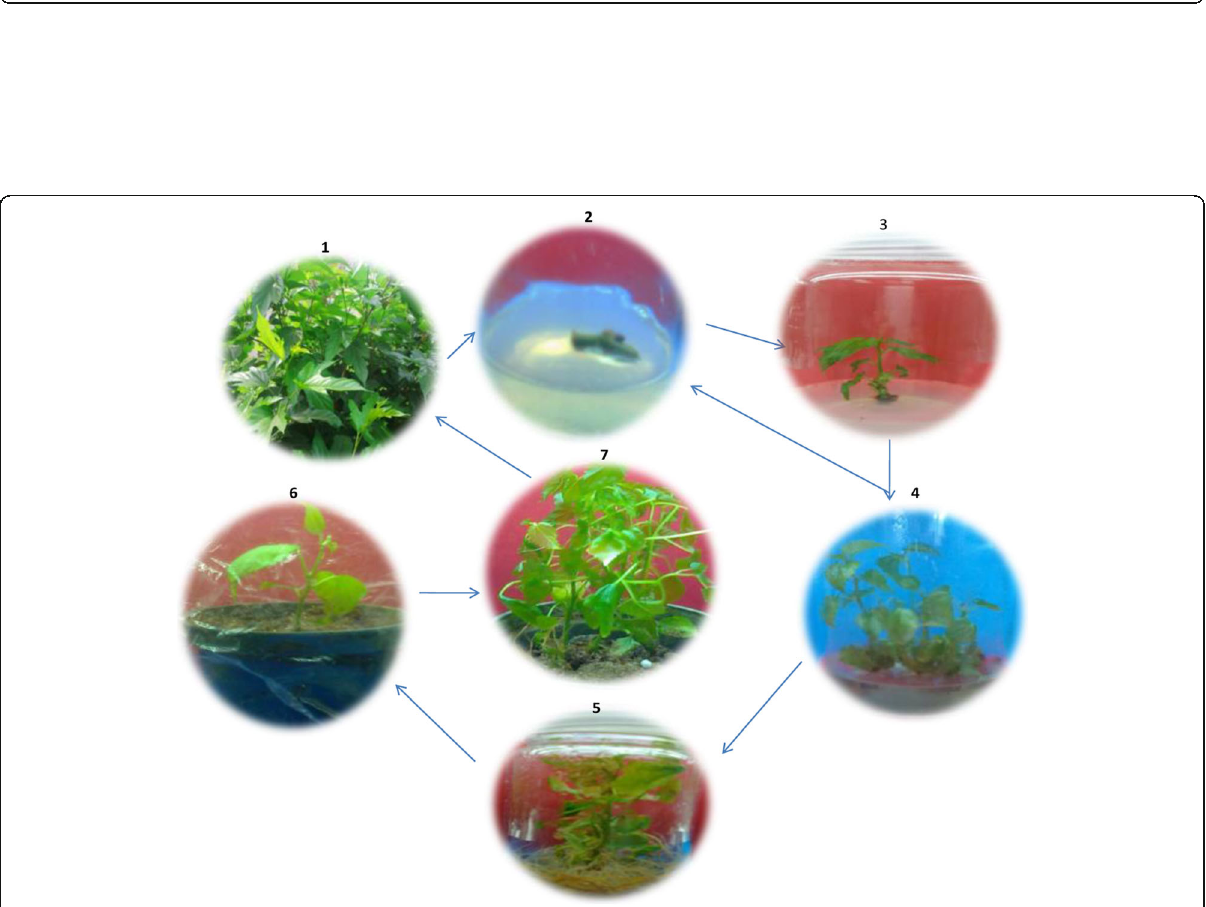
Fig. 7 Diagram of in vitro propagation of Morus alba var Canava2, showing the mulberry plant in the field (1), internode explant (2), in vitro shootlet initiation (3), multiplication (4), root formation (5), acclimatization (6), and hardening mulberry plantlets